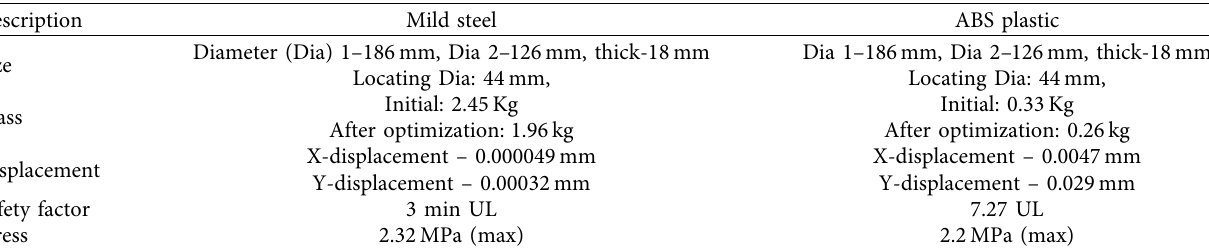
Figure 8: Topology optimized mechanism and robotics clamp plate design. Table 3: Objective functions–steel plate vs ABS